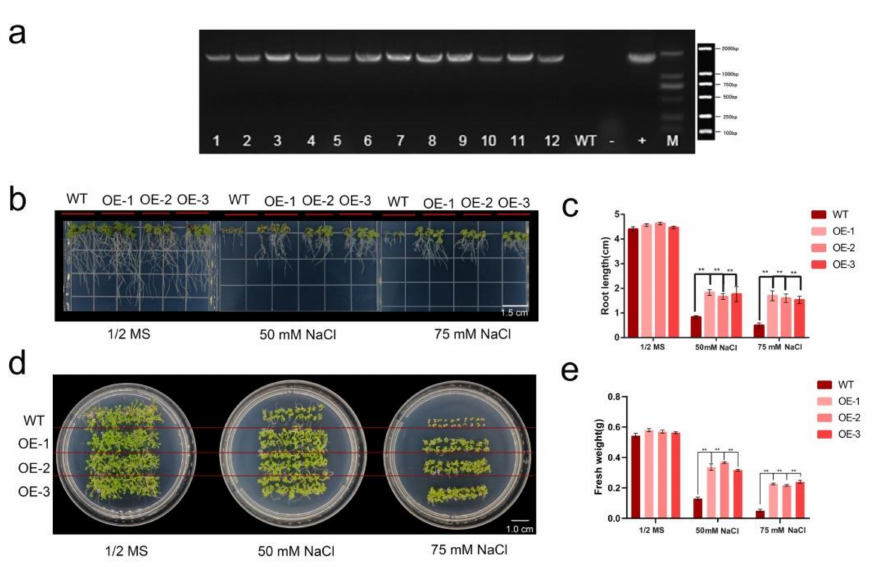
Figure 7. Genes involved in the response to salt stress in H. hamabo transcriptomes. Construction of HhWRKY79 overexpression of A. thaliana plants and phenotypic changes under salt stress. ( a ) Hh- WRKY79 overexpression A. thaliana gel map test results. M, 2000 bp marker; +, plasmid; − , empty vector; WT, wild-type A. thaliana ; OE1-12, transgenic plants. ( b ) Comparison between root lengths in WT and transgenic A. thaliana under different concentrations of NaCl. ( c ) Statistic histogram of root length in WT and transgenic A. thaliana under different concentrations of NaCl. ( d ) Comparison of the growth of WT and transgenic A. thaliana under different concentrations of NaCl. ( e ) Statistical histogram of the fresh weight of WT and transgenic A. thaliana under different concentrations of NaCl. Significance was analyzed using Student’s t -test (** p <